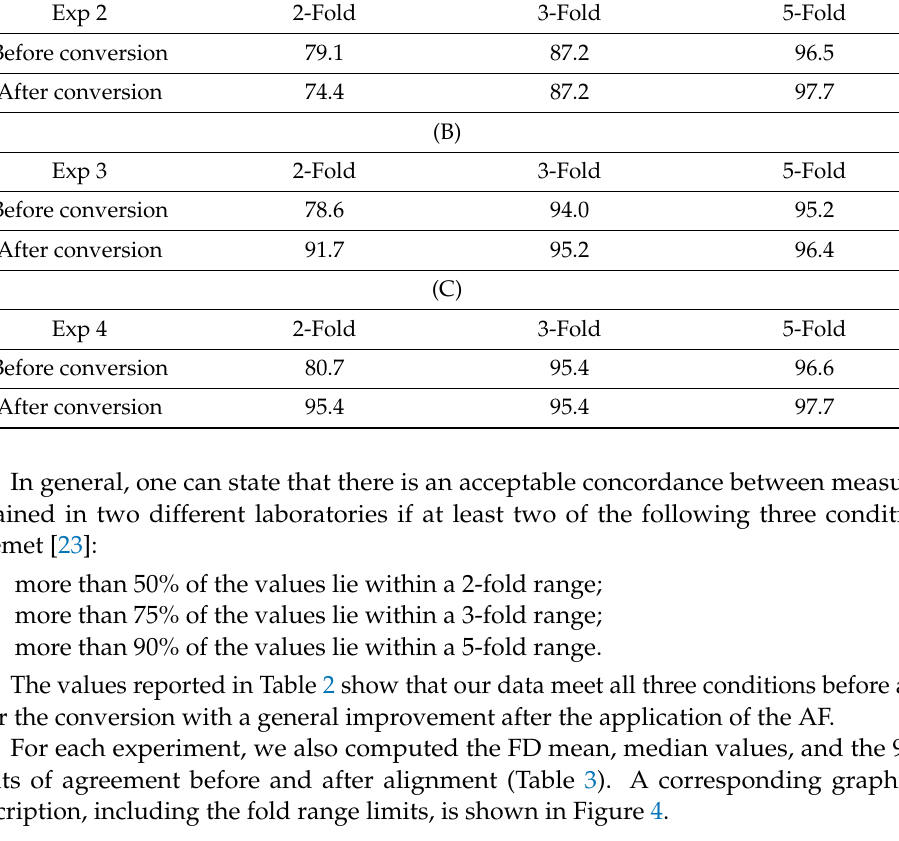
Table 2. Percentages of measurements, before and after conversion, that lie within a 2-, 3-, and 5-fold range for Exp2, Exp3, and Exp4 presented under (A), (B), and (C) respectively. (A) Exp 2 2-Fold 3-Fold 5-Fold Before conversion 79.1 87.2 96.5 After conversion 74.4 87.2 97.7 (B) Exp 3 2-Fold 3-Fold 5-Fold Before conversion 78.6 94.0 95.2 After conversion 91.7 95.2 96.4 (C) Exp 4 2-Fold 3-Fold 5-Fold Before conversion 80.7 95.4 96.6 After conversion 95.4 95.4